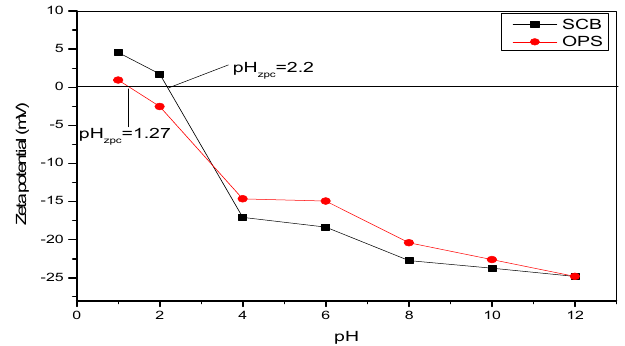
Figure 1. Zeta potential of SCB and OPS.